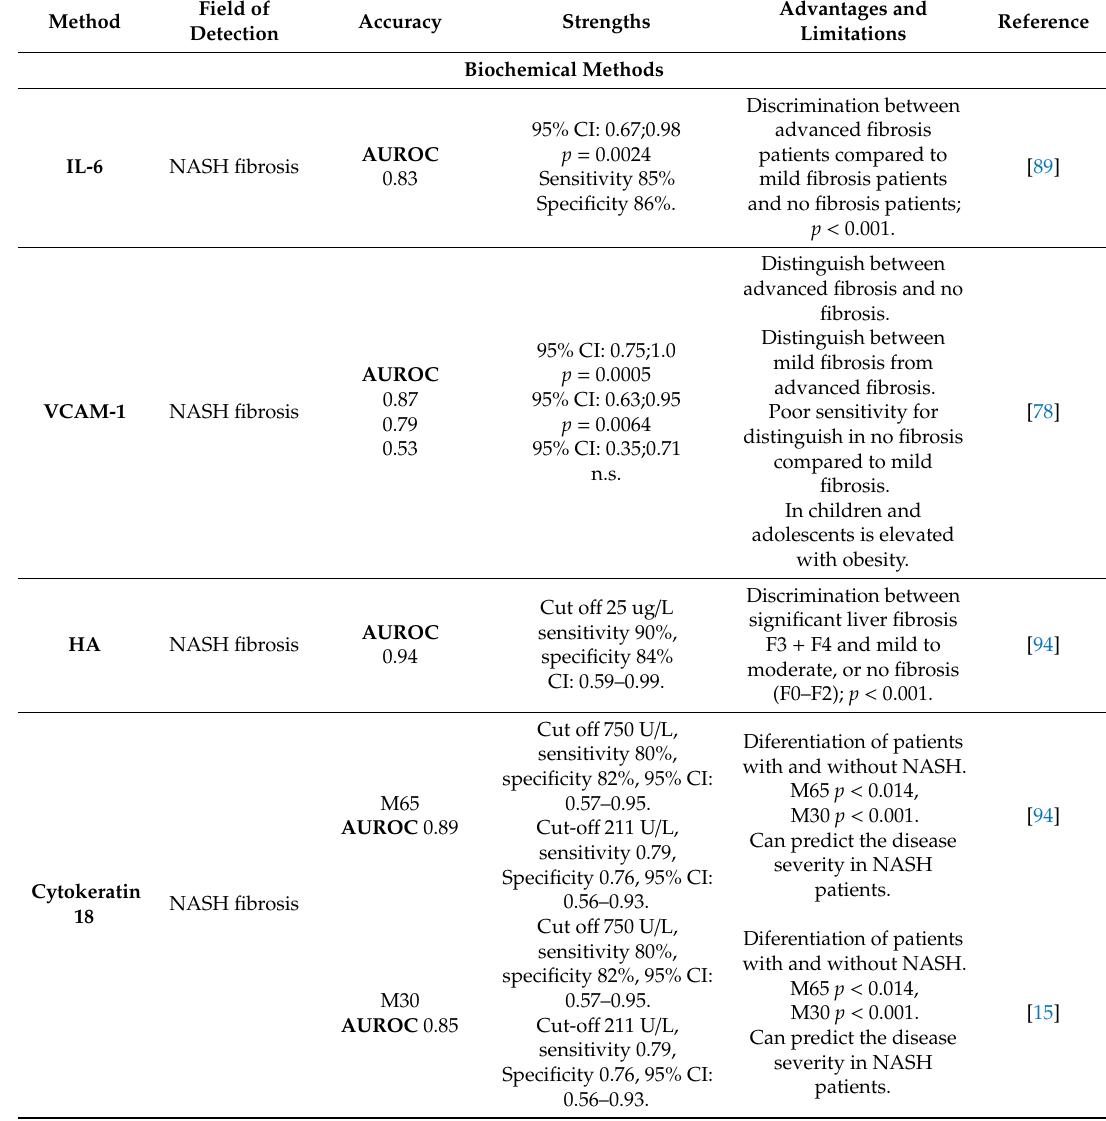
Legend: IL-6—interleukin 6, VCAM-1—vascular cell adhesion protein 1, HA—hyaluronic acid, CI—confidence interval, AUROC—area under the receiver-operating characteristic